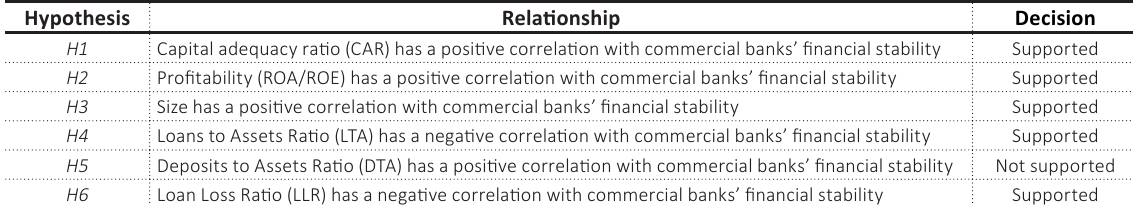
Table 5. Hypotheses testing